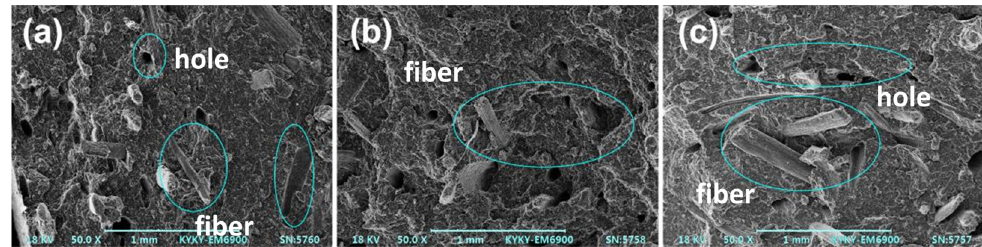
Figure 9. SEM micrographs of PP/SF flame-retardant composites. ( a ) (PP/IFR)/SF; ( b ) (PP/SF)/IFR; ( c ) PP/IFR/SF.